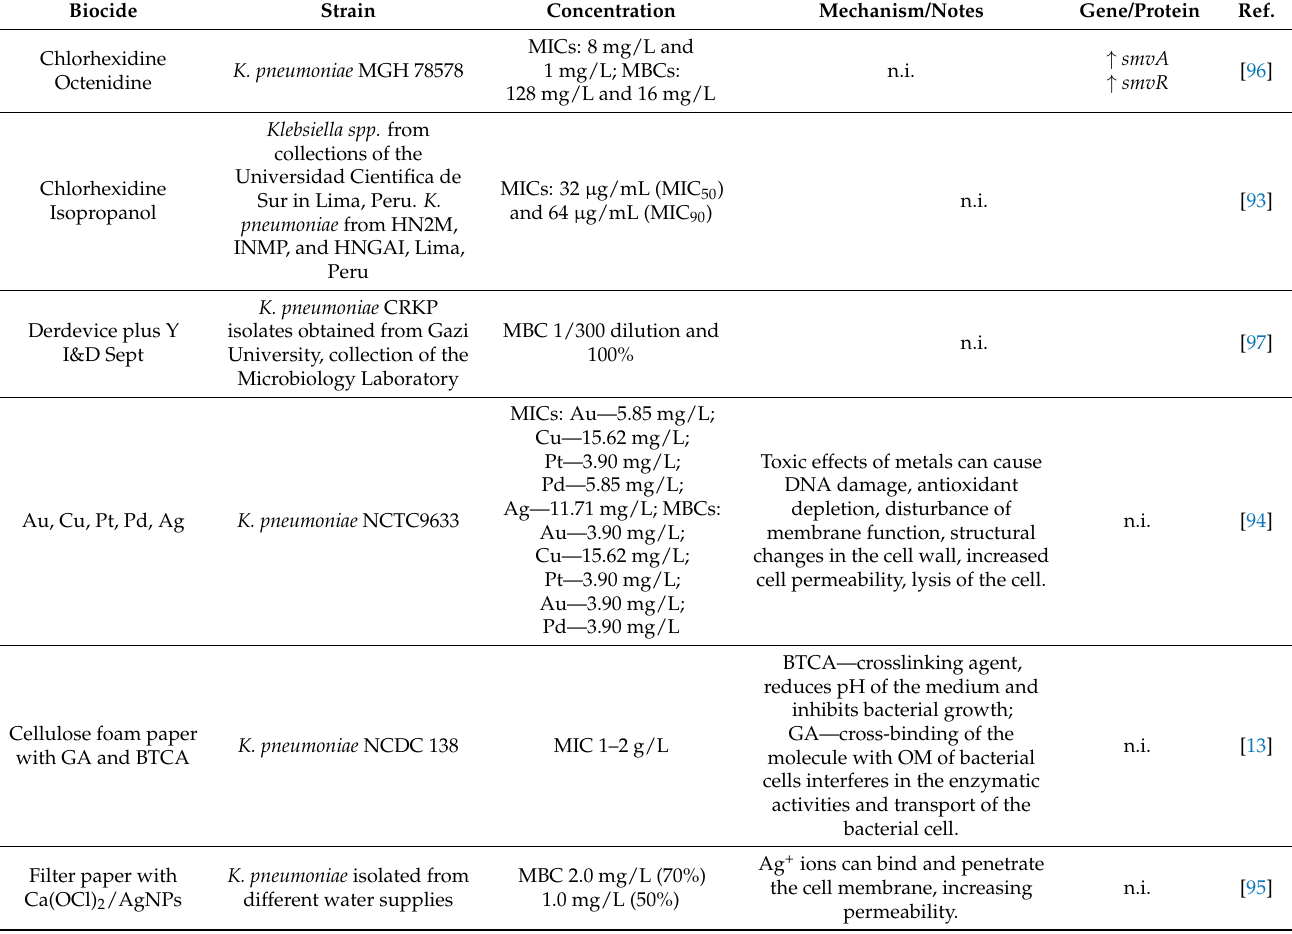
Table 3. Biocides and their impact on Klebsiella